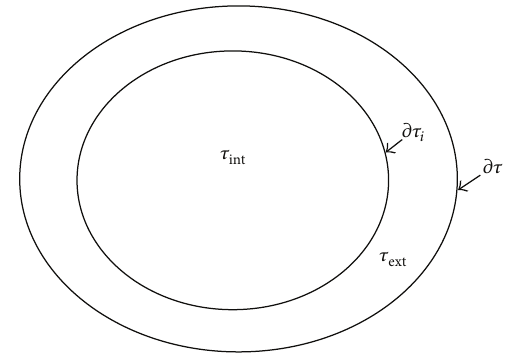
Figure 3: The macroscopic continuum region 𝜏 consisting of interacting on the surface 𝜕𝜏 𝑖 of the the subsystems 𝜏 int and 𝜏 ext continuum velocity